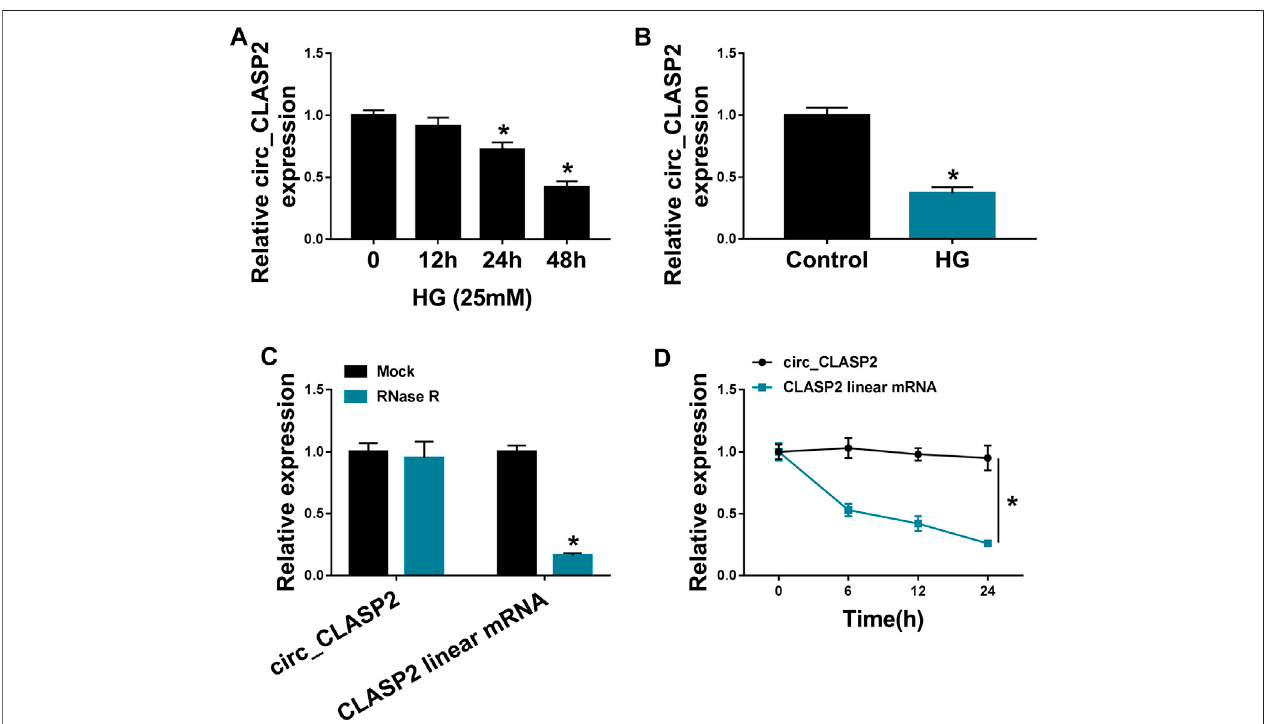
FIGURE1| HGtreatmentreducedcirc_CLASP2expressioninHUVECs. (A) HUVECsweretreatedwith25 mMofHGfor12,24,and48 h,andthencirc_CLASP2 expression was assessed by qRT-PCR. (B) Circ_CLASP2 level was detected by qRT-PCR in HUVECs after the treatment of 25 mM of HG for 48 h. (C) Total RNA from HUVECs was incubated with RNase R, followed by the detection of circ_CLASP2 and CLASP2 linear mRNA by qRT-PCR. (D) The levels of circ_CLASP2 and CLASP2 linearmRNAweremeasuredbyqRT-PCRinHUVECstreatedwithactinomycinD.n (cid:2) 3independentbiologicalreplicates;datawerepresentedasmean ± SD;* p < 0.05 by a two-tailed Student ’ s t -test or ANOVA followed by Tukey – Kramer post hoc